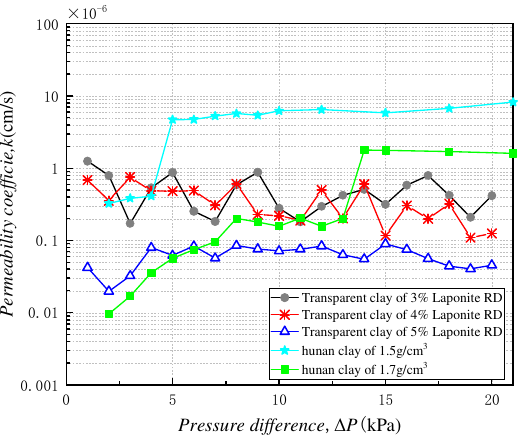
Figure 5. Line graph of the variation of permeability coefficient with the difference of permeability pressure for specimens with different mass mixing